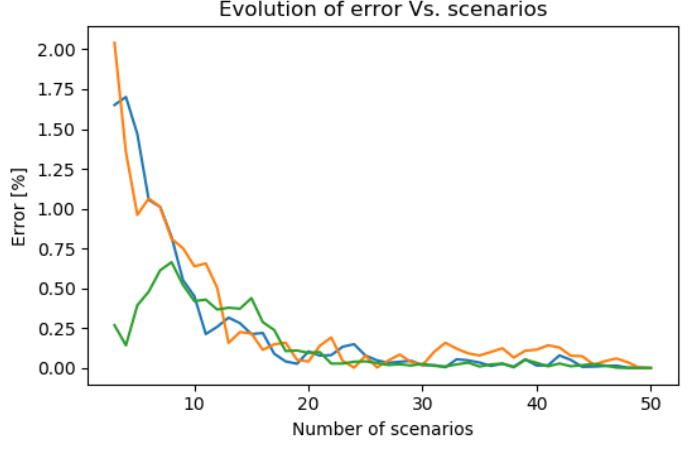
Figure 8. Error evolution as a function of price scenarios for the stochastic solution for three independent